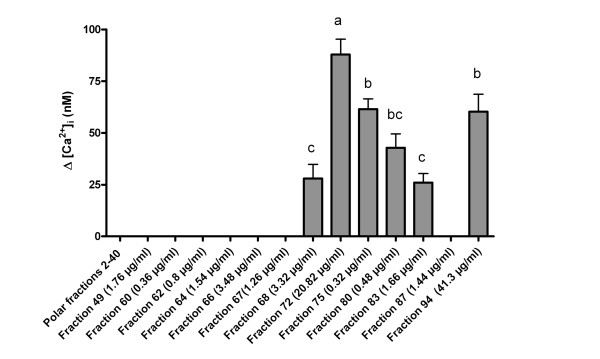
Fractionation by preparative HPLC of the Ca2+-inducing activity in E. purpurea root ethanol extracts. HPLC-separated fractions from 95% ethanol extract of E. purpurea root induce significantly different levels of Ca2+ response. Fraction numbers refer to the time (in minutes) when each fraction eluted from the HPLC column. Bar graphs show the mean values of the transient increase in cytosolic Ca2+ concentration evoked by different fractions (mean ± SEM, n = 3, from three independent experiments). There was no detectable response from fractions #2-67 and fraction #87. Different letters indicate statistically significant differences (p < 0.05) between the cytosolic Ca2+ increase of the six active fractions by one-way analysis of variance followed by the Tukey test.